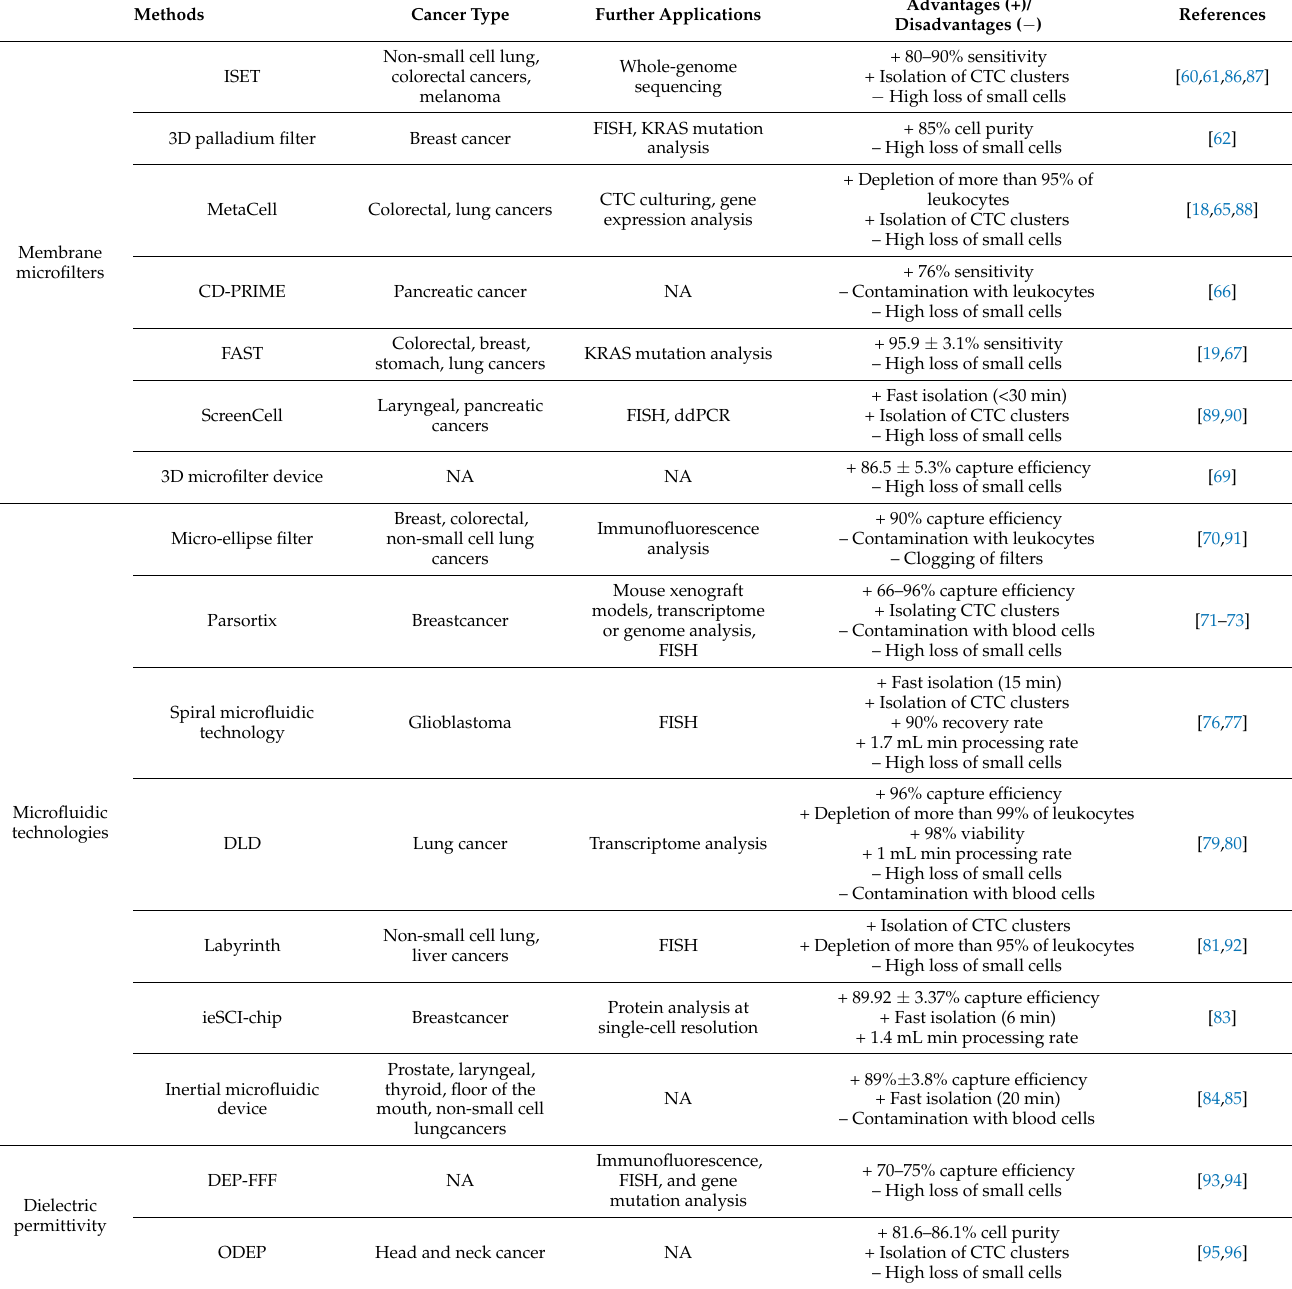
Table 1. Cell size-based methods for isolating viable